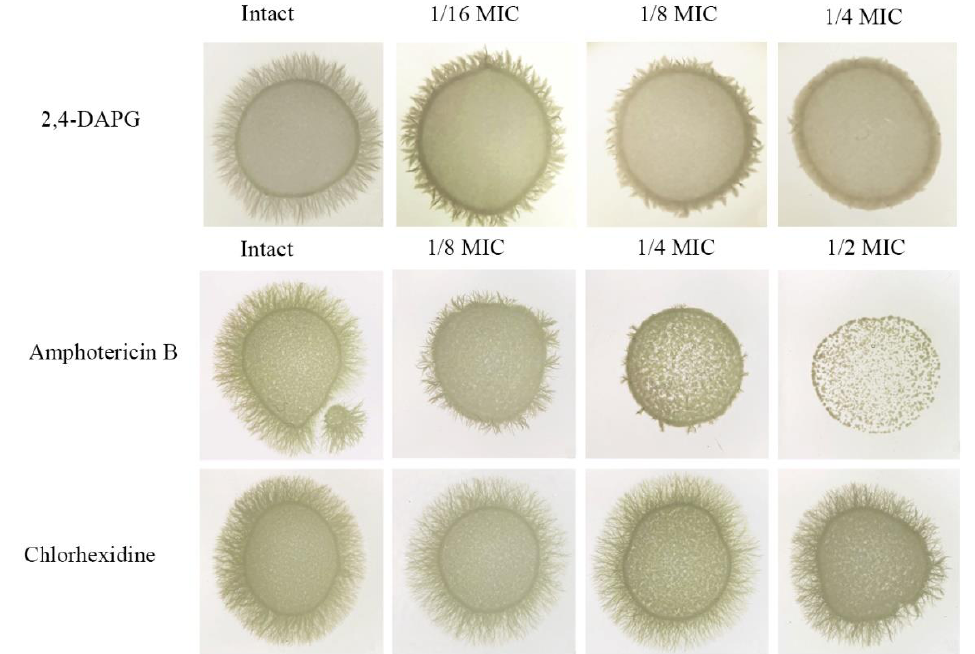
Figure 6. Yeast-to-hyphae transition of C. albicans ATCC 10231 on spider agar in the presence of sub-inhibitory concentrations of various antifungals. 2,4-DAPG was added at 31 µg/mL (1/4 MIC); 15.5 µg/mL (1/8 MIC); 7.5 µg/mL (1/16 MIC); and 0 µg/mL. Amphotericin B was added at 0.15 µg/mL (1/2 MIC), 0.075 µg/mL (1/4 MIC) and 0,037 µg/mL (1/8 MIC); chlorhexidine was added at 0.0003% (1/2 MIC), 0.00015% (1/4 MIC) and 0.00007 (1/8 MIC).